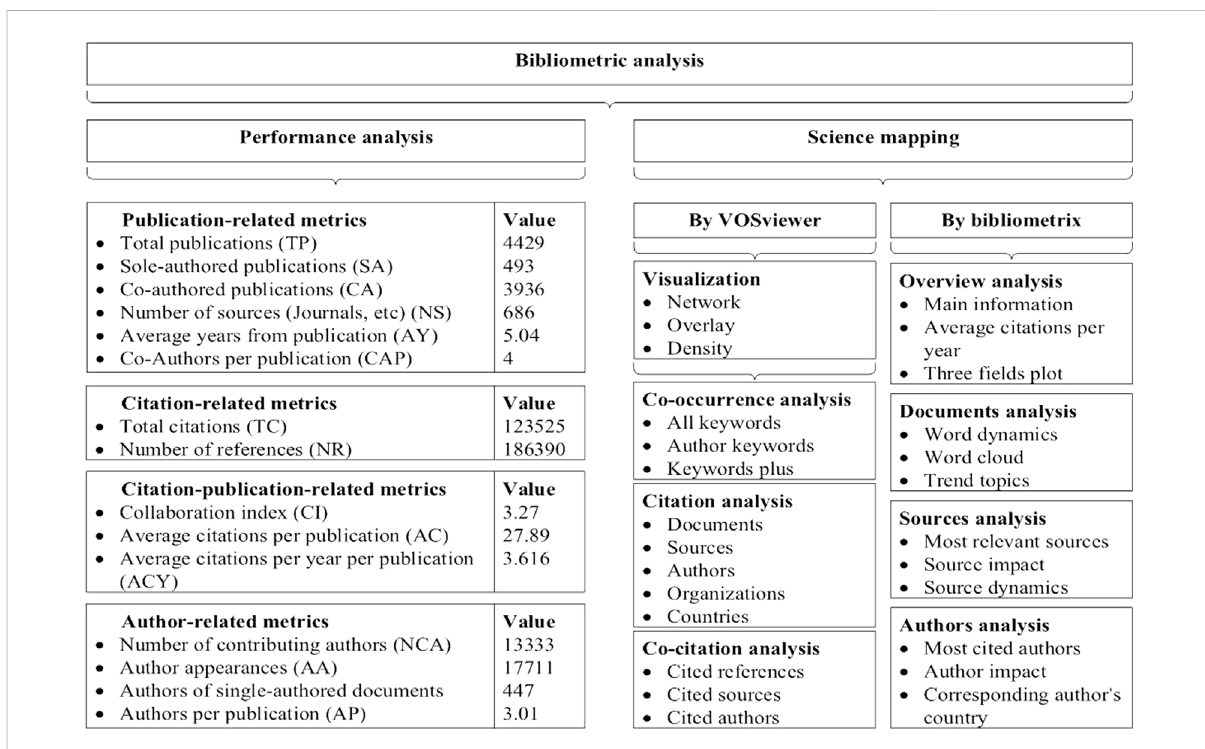
FIGURE 1 Overview of the bibliometric analysis in this